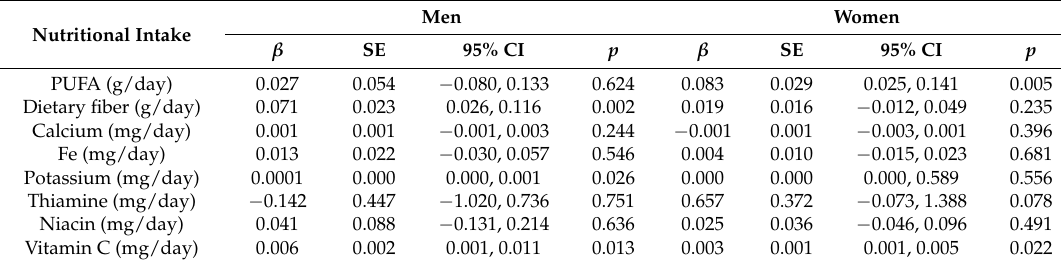
Table 5. Associations between handgrip strength and nutritional